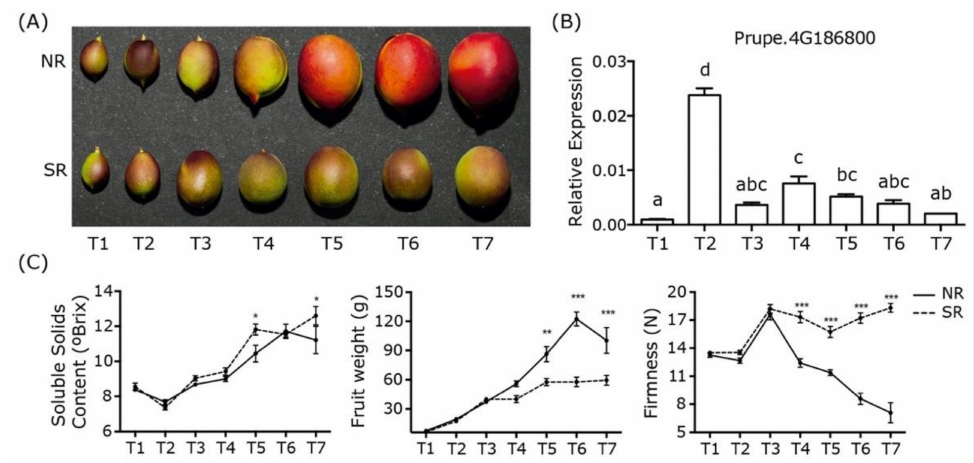
Figure 1. Slow ripening versus normal ripening fruit phenotypes. Fruit changes between normal and slow ripening phenotypes at different developmental stages. The evaluation stages T1, T2, T3, T4, T5, T6 and T7 represent different days after 1 September (DASF), corresponding to 37, 51, 65, 79, 99, 112 and 120 DASF, respectively. ( A ) Photographic developmental evaluation of fruit with normal (NR) and slow (SR) ripening phenotypes. ( B ) Expression profile of the candidate gene Prupe.4G186800 ( NAC072 ) during normal phenotype development. Letters a-d represent significant expression differences. ( C ) Changes in soluble solid content, fruit weight and firmness between NR (continuous lines) and SR (dashed lines) phenotypes. Significant differences between NR and SR phenotypes are represented with asterisk (* p < 0.05; ** p < 0.01; *** p <